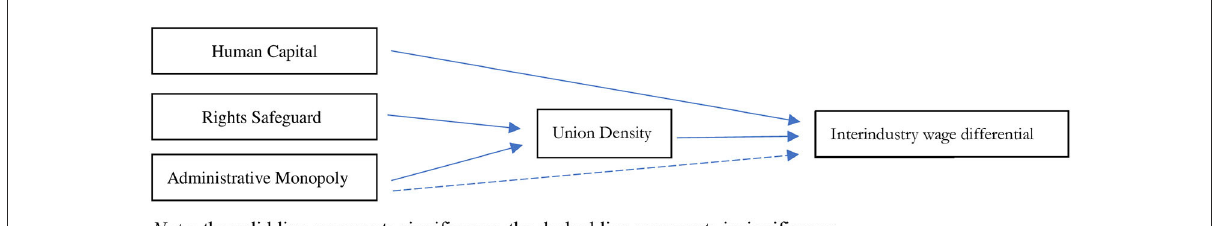
FIGURE6 The relationship between union density and